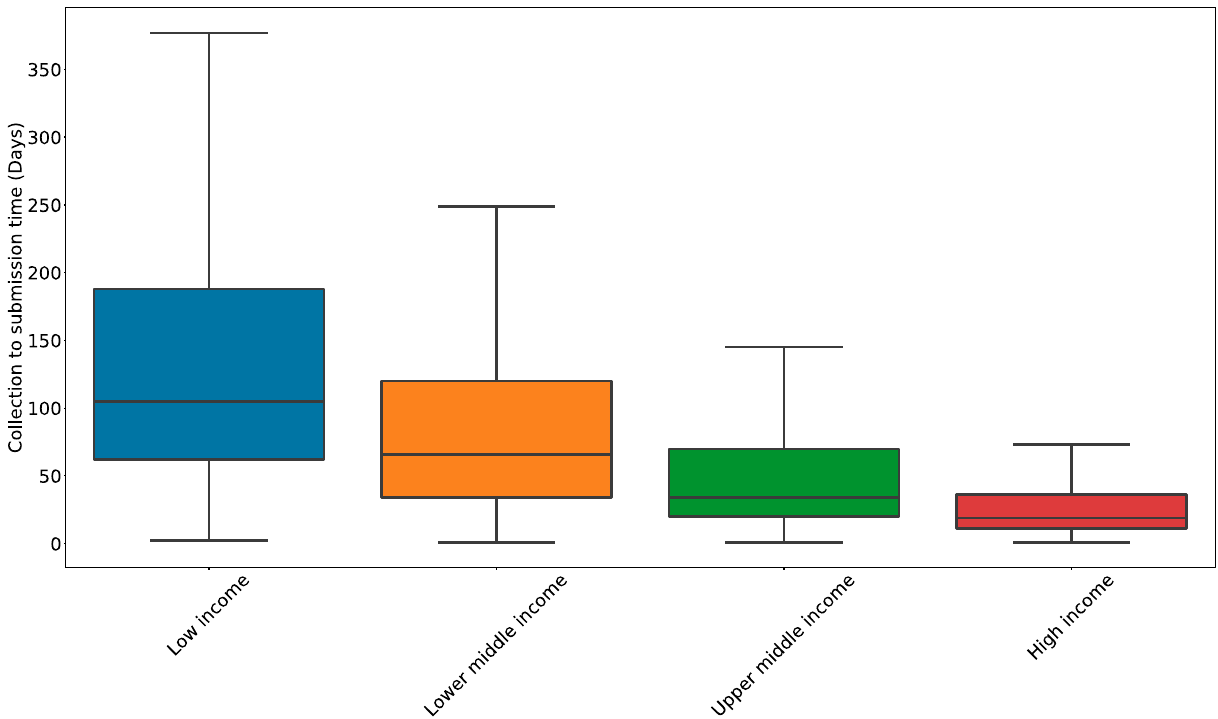
Figure 3. Lag time from specimen collection to sequence reporting on GISAID by income status. Data were pulled from GISAID (accessed 5 September 2022) and Worldbank and are presented as a boxplot. The box represents the lower and upper quartiles (Q1 and Q3, respectively) and the line within the box represents the median. The whiskers represent the rest of the data distribution except for the points deemed outliers (defined as 1.5 × IQR + Q3 or 1.5 × IQR − Q1 where IQR = Q3 − Q1).